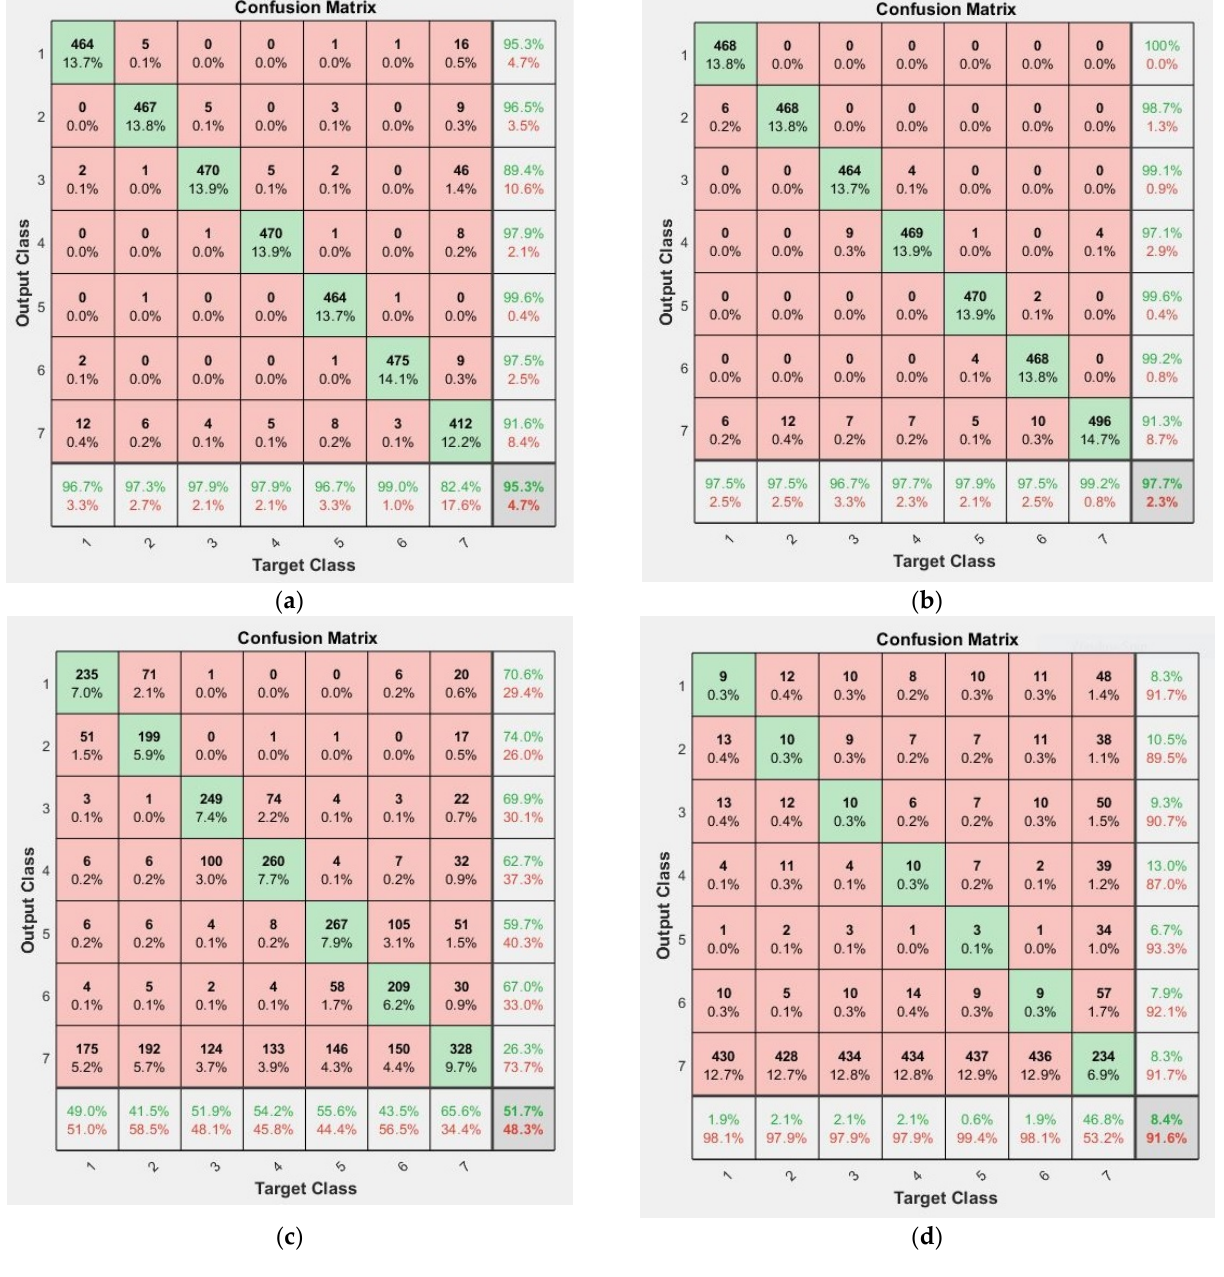
Figure 7. ( a ) Confusion matrix on dataset A using greyscale images; ( b ) confusion matrix on dataset B1 using spectrogram images; ( c ) confusion matrix on dataset B2; ( d ) confusion matrix on dataset B3.